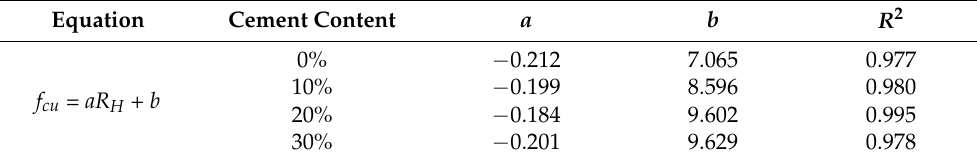
Table 8. The fitting results of the compressive strength ( f cu ) and relative humidity ( R H ). Equation Cement